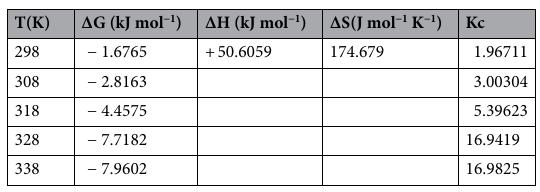
Table 9. Thermodynamic parameters for adsorption of Cu 2+ onto nZVI.